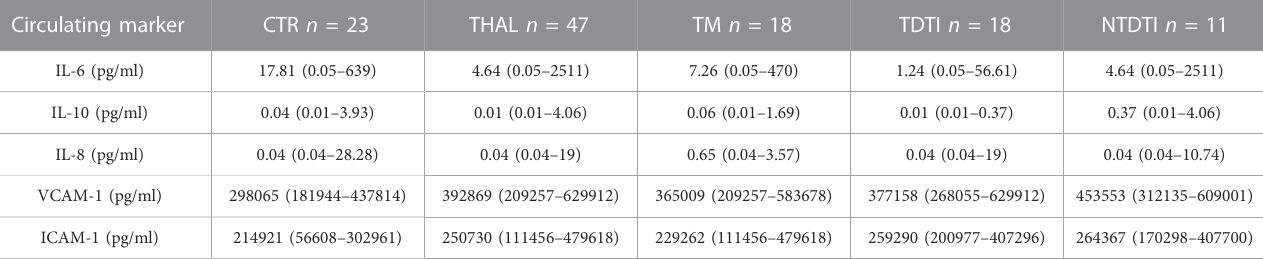
TABLE 2 Circulating levels of cytokines, chemokines and adhesion molecules in plasma from patients and healthy subjects. Data are reported as medians and range values. Circulating marker